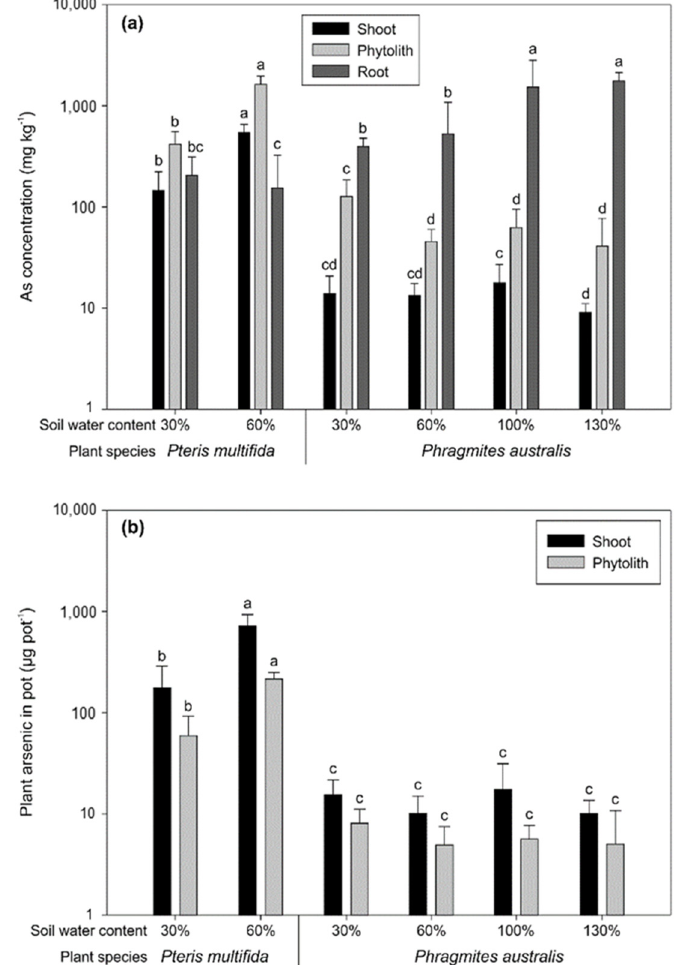
Figure 2. Arsenic in Pteris multifida and Phragmites australis as a function of the water content. ( a ) As concentration in plant shoot, phytolith, and roots. As in the shoot and roots was calculated based on plant dry weight, and As in phytoliths was calculated based on phytolith weight. ( b ) The amount of As in plant shoots and phytoliths for each pot. Water content means the percentage of water holding capacity. Different letters in the same color bar indicate significant differences at the 5% level determined via Duncan’s test after log-scale